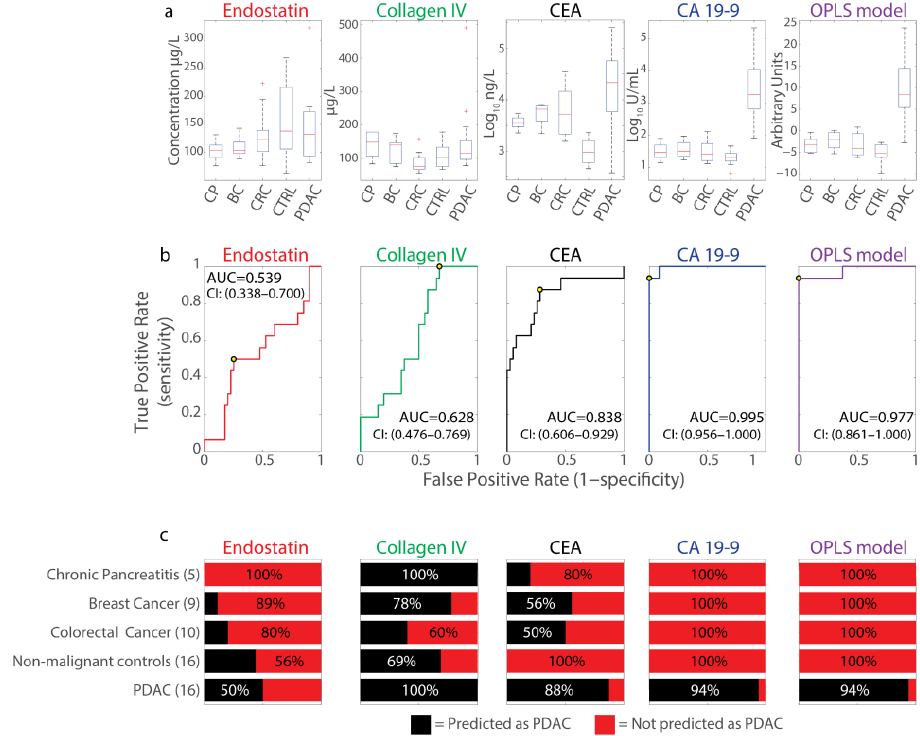
Figure 3. Separating PDAC cases from controls with other cancer forms, inflammatory disease, and non-malignant diseases at the time of diagnosis in the Umeå prospective clinical biobanks (UPCB) cohort. ( a ) Box plots of the measured EDTA plasma biomarker values from samples provided by patients or controls. Median values are indicated by the red line in the box, and values outside plotted whiskers are indicated by a red cross. Y-axis plotted linearly except for measures from CEA and CA19-9, which are on a log 10 scale. CP, chronic pancreatitis; BC, breast cancer; CRC, colorectal cancer; CTRL, non-malignant controls; PDAC, pancreatic adenocarcinoma. ( b ) ROC curves displaying sensitivity and false positive rate (1-specificity) of measured circulating biomarker levels (endostatin, collagen IV, CEA, and CA19-9) and a multivariate OPLS-DA model combining all four markers for PDAC detection. Samples were measured from PDAC patients at time of diagnosis ( n = 16) and compared against other controls ( n = 40, Table 2) for the analysis, including patients with breast cancer ( n = 9), colorectal cancer ( n = 10), CP ( n = 5), or with non-malignant disease ( n = 16). Area under the curve (AUC) is specified in each graph and the optimal cut-off point indicated with a circle. ( c ) Percentage of individuals predicted to have PDAC (in black) or not (in red) for the different markers and the OPLS-DA model for each patient category using the optimal cut-off.